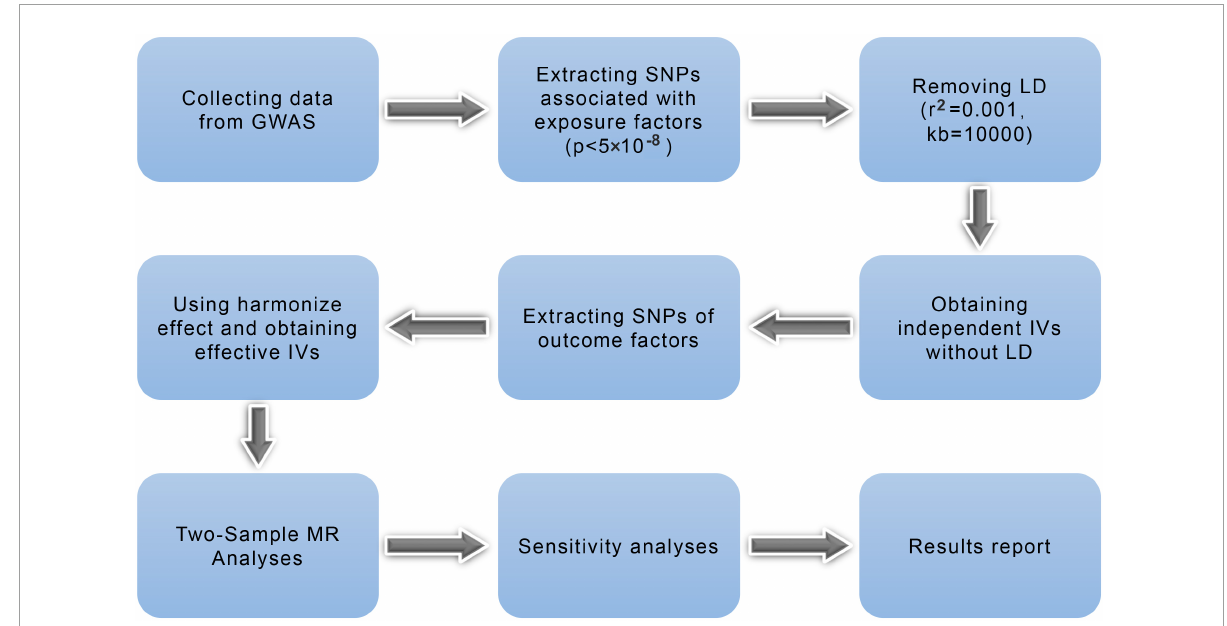
FIGURE2 Mendelian randomization study flowchart. The blue boxes represent research steps while gray arrows indicate the overall direction. GWAS, genome-wide association study; IV, instrumental variable; LD, linkage disequilibrium; MR, Mendelian randomization; SNP, single-nucleotide